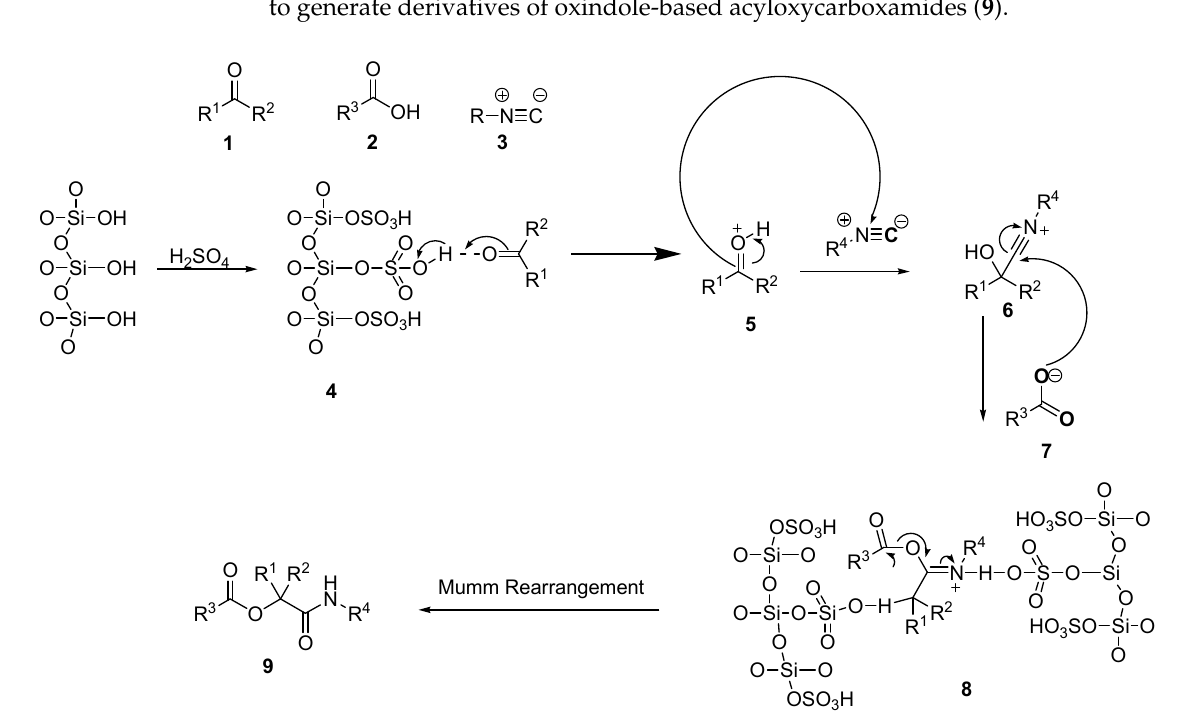
Scheme 7. Proposed mechanism for the formation of α -acyloxycarboxamides in the presence of the immobilized sulfuric acid on silica gel (SiO 2 -H 2 SO 4 ). immobilized sulfuric acid on silica gel (SiO 2 -H 2 SO 4